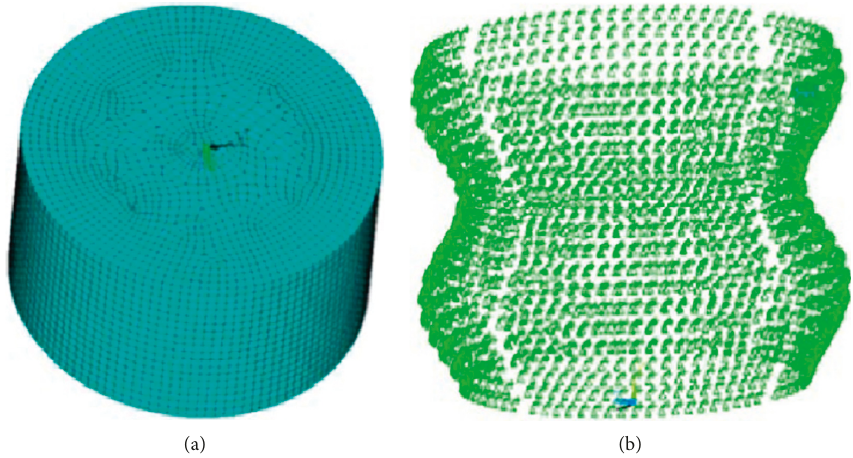
Figure 7: Finite element (FE) models: (a) FE mesh diagram and (b) the distribution of spring units.